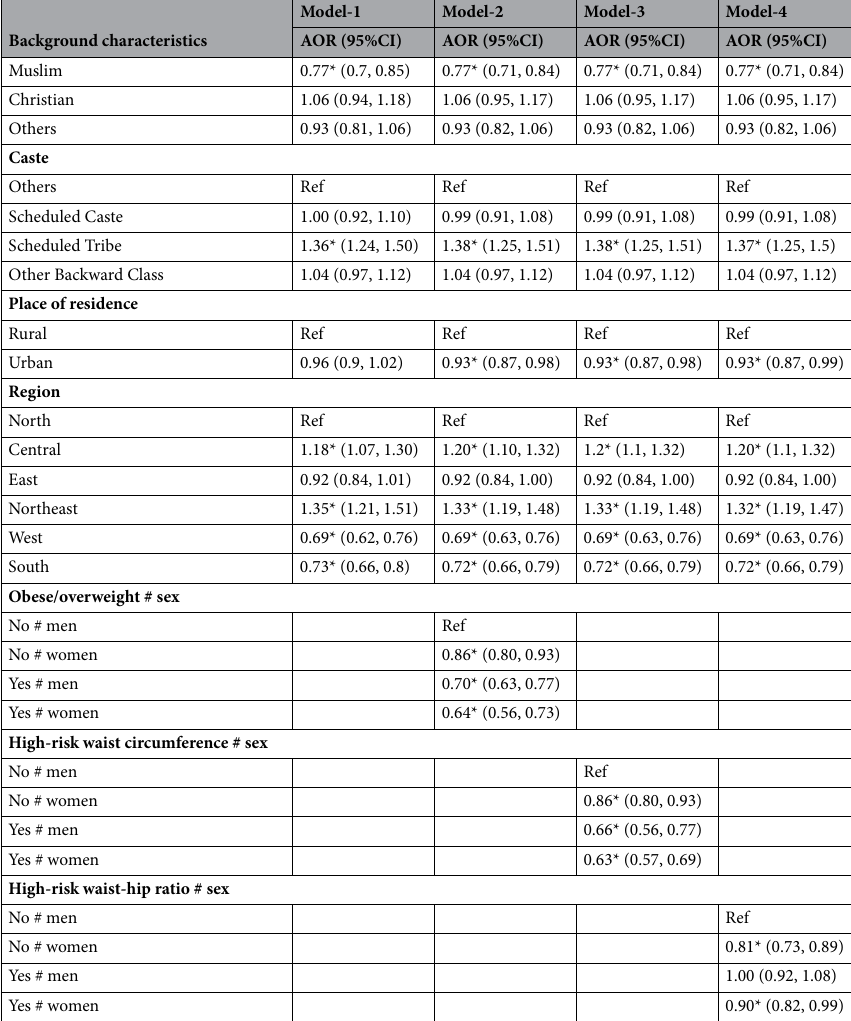
Table 3. Logistic regression estimates of successful ageing among older adults by obesity-related measures and socioeconomic and demographic characteristics in India, 2017–2018. Model-1, 2, 3 and 4 was controlled for all individual and household characteristics. Ref: reference, #: interaction, MPCE: monthly per capita consumption expenditure, AOR: adjusted odds ratio, CI: confidence interval. *if p <